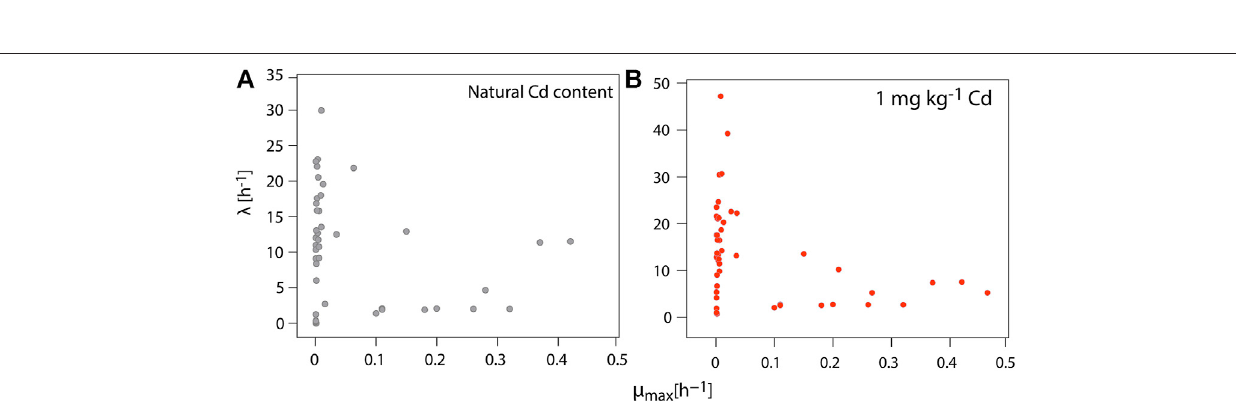
FIGURE3| APearsoncorrelationbetweenheat- fl owandthemaximumheatobtainedbyIMCofcompositesoilsamplesexposedto (A) naturalCdcontentand (B) an amendment with 1 mg kg − 1 CdCl 2 ( p ≤ 0.005).